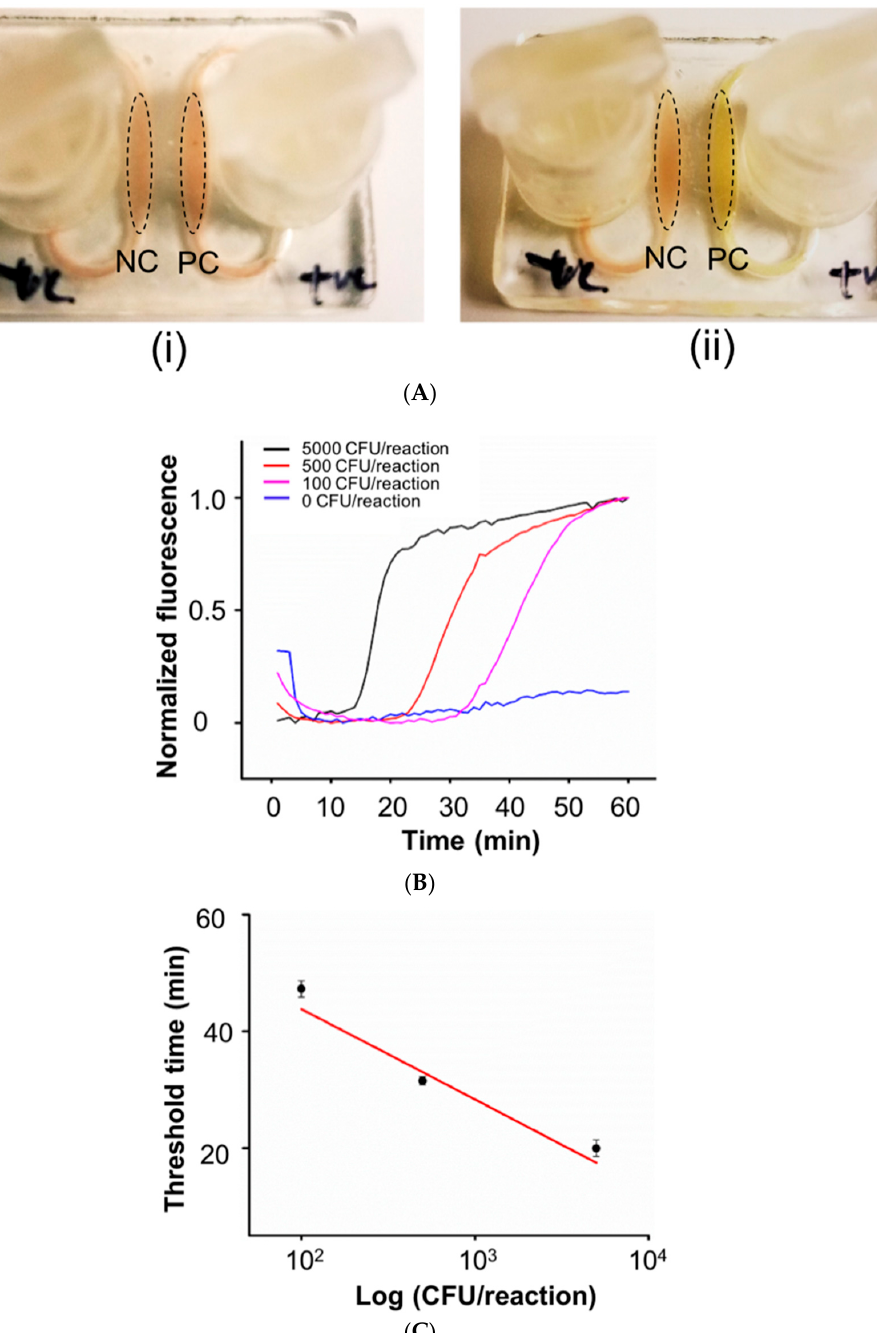
Figure 6. ( A ) Colorimetric LAMP assay of S. Thyphi bacterial DNA in our hard–soft hybrid microfluidic chip (i) before and (ii) after LAMP amplification. ( B ) Real-time fluorescence monitoring of LAMP amplification of S.Thyphi bacterial DNA with 0, 100, 500, 5,000 CFU per reaction. ( C ) Threshold time Tt (in minutes), as a function of function of log S.Thyphi bacterial DNA concentration (expressed in terms of CFU per reaction) (n = 3).